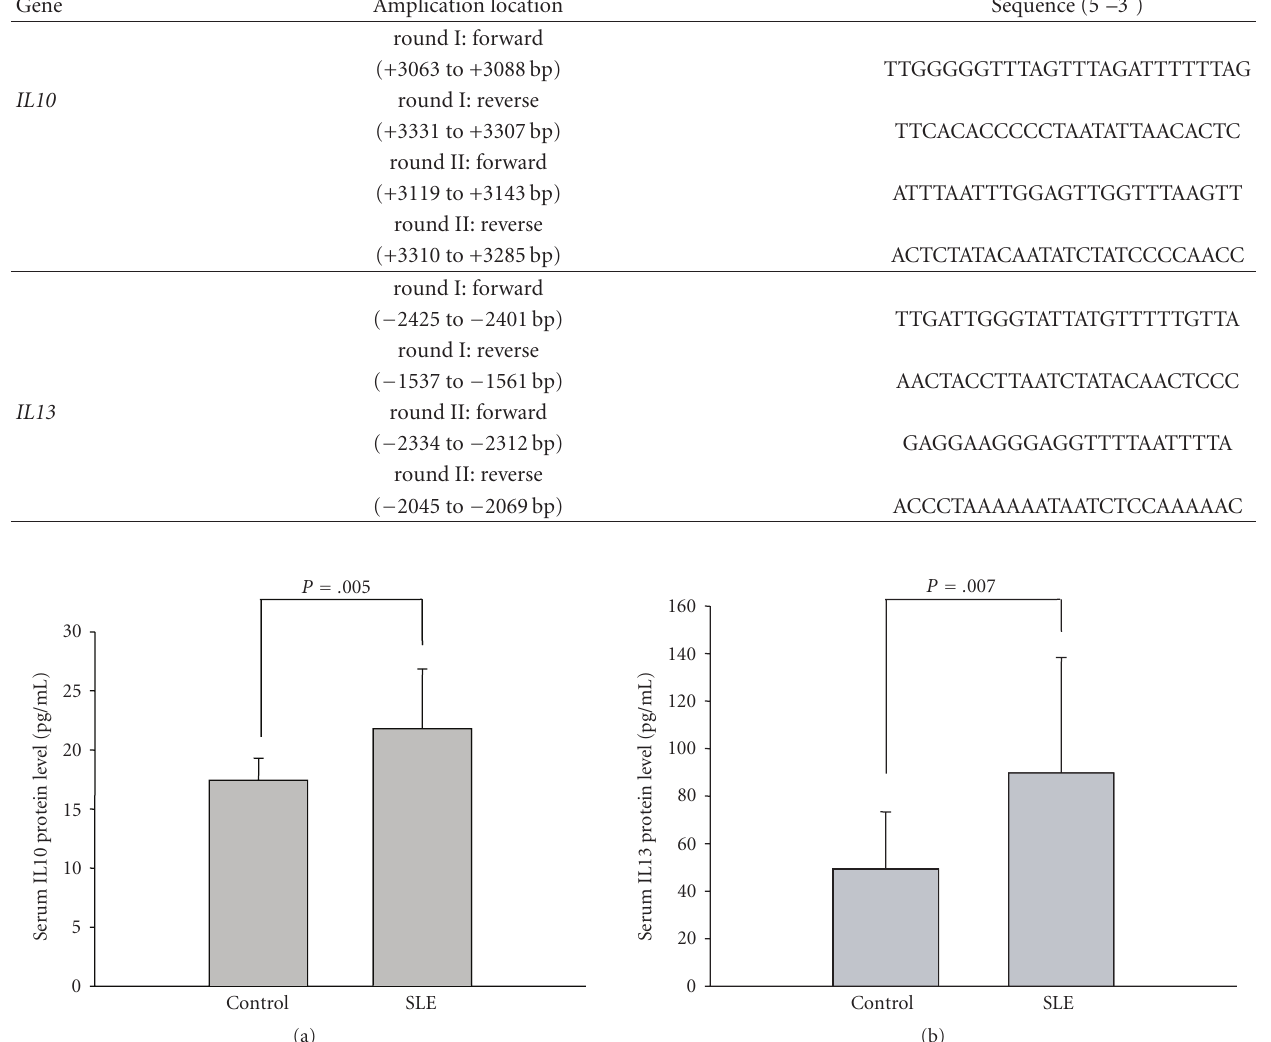
were considered significant. All analyses were performed with SPSS Version 13.0